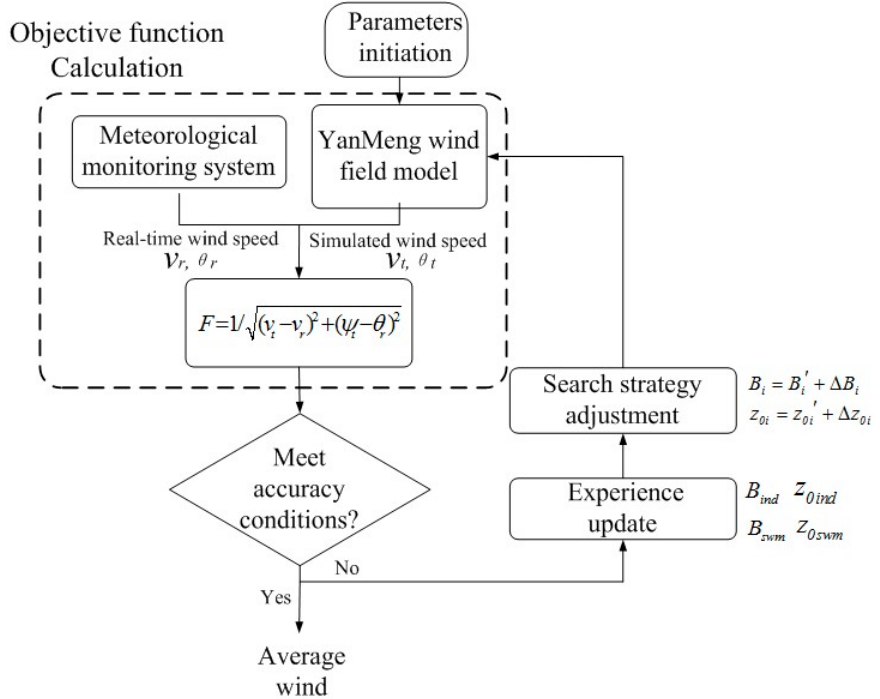
Figure 3. The flowchart of YanMeng-particle swarm optimization (PSO) algorithm.